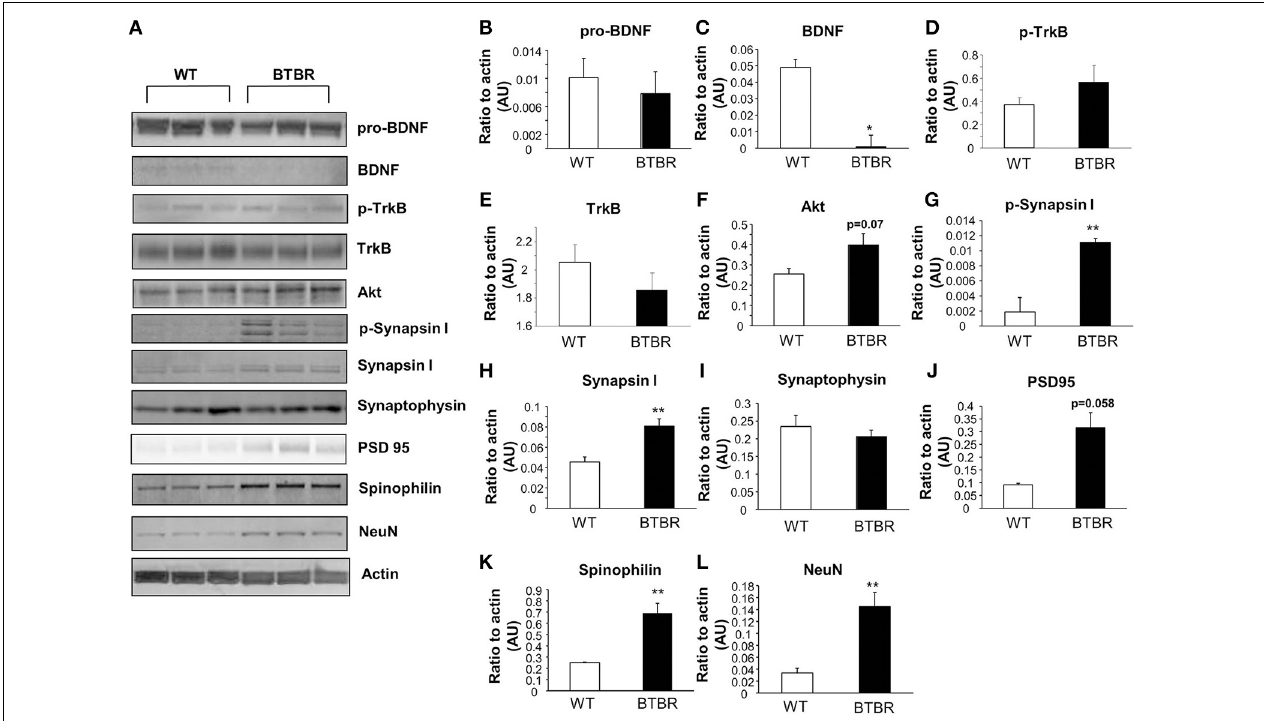
FIGURE 3 | Protein expression in wild type and BTBR mouse hippocampus. Western blotting was performed using mouse hippocampal protein lysates (A) . Protein levels were measured in BTBR and control mice with respect to the following proteins in the hippocampus: pro-BDNF (B) , mature BDNF (C) , phospho-TrkB (D) , total